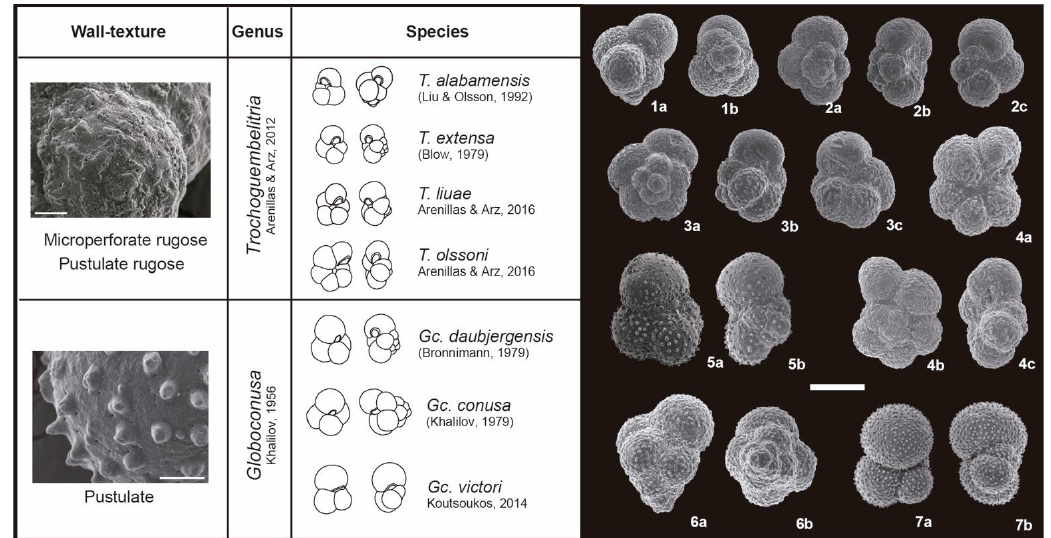
Figure A2. Species of Trochoguembelitria and Globoconusa . 1. Trochoguembelitria alabamensis ; 2. T. extensa ; 3. T. liuae ; 4. T. olssoni ; 5. Globoconusa daubjergensis ; 6. Gc. conusa ; 7. Gc. victori . See main diagnostic characters of these species and genera in Supplementary Text S1. Specimens are from El Kef (1–4), Bajada del Jagüel (5), Ben Gurion (6), and Campos Basin, offshore Brazil (7; specimen reported by Koutsoukos [5]). Scale bar = 100 µ m.